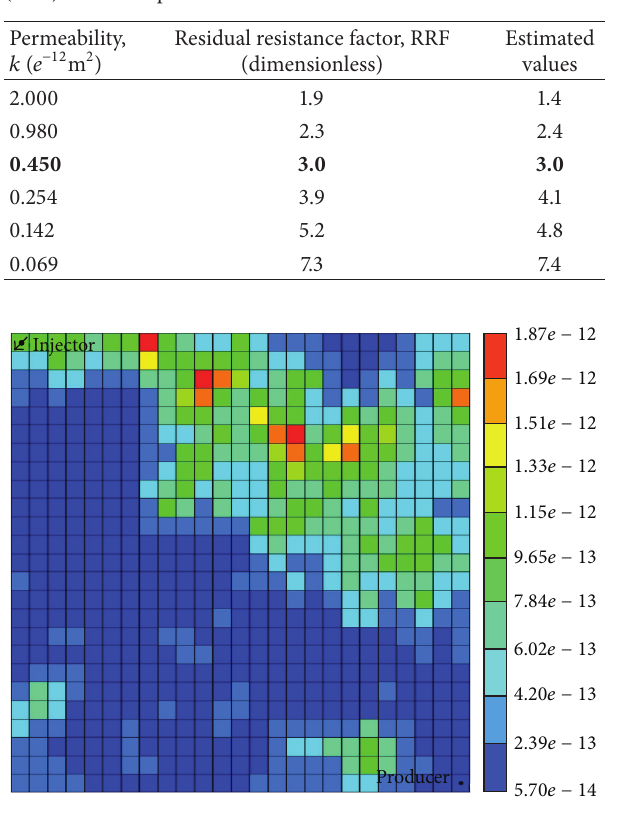
Figure 6: Permeability distribution of heterogeneous reservoir (m 2